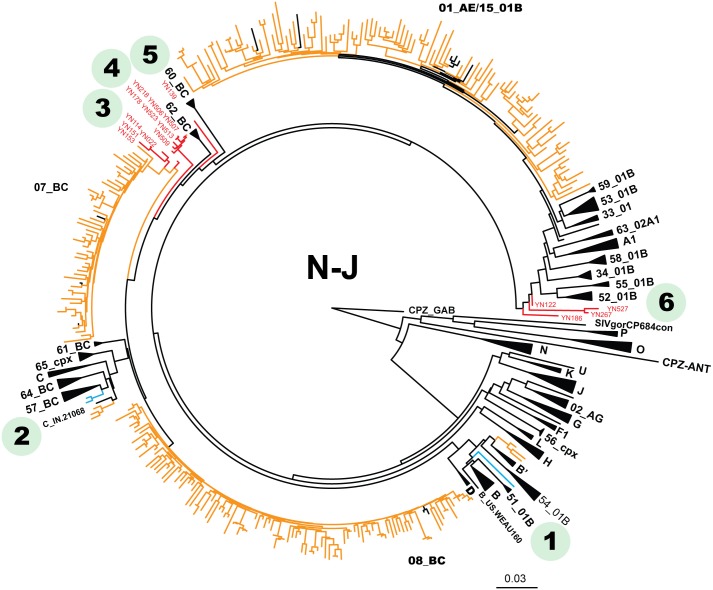
Phylogenetic neighbor-joining tree of HIV pol sequences from infected subjects sampled in Banna from 2009 to 2011.The sample sequences with ambiguous genotype were highlighted in blue and red, and labeled with numbers from 1 to 6 simultaneously. 1 and 2 indicated sequences can’t be well distinguished by this sequencing region, and were designated as B/CRF51_01B and C/CRF57_BC respectively. 3 to 6 indicated 16 clustered unique recombinant forms. Other sample sequences and reference sequences were showed in light brown and black respectively.